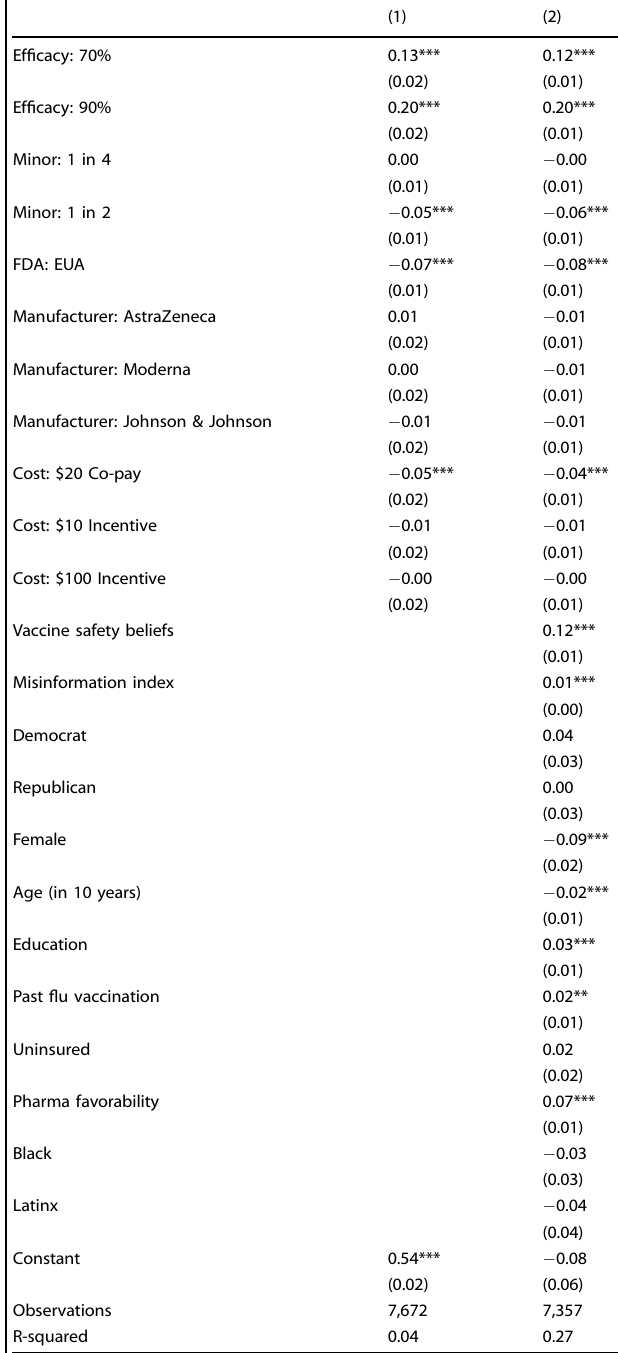
Table 3. Effects of vaccine attributes on willingness to